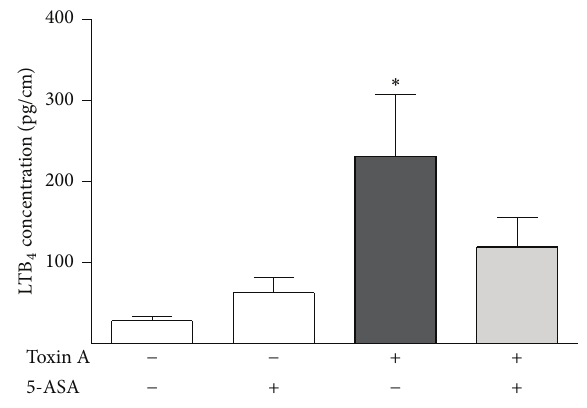
Figure 2: Effects of 5-ASA, toxin A, and toxin A after pretreatment with 5-ASA on colonic tissue LTB 4 concentrations. ∗ 𝑃 < 0.01 versus no